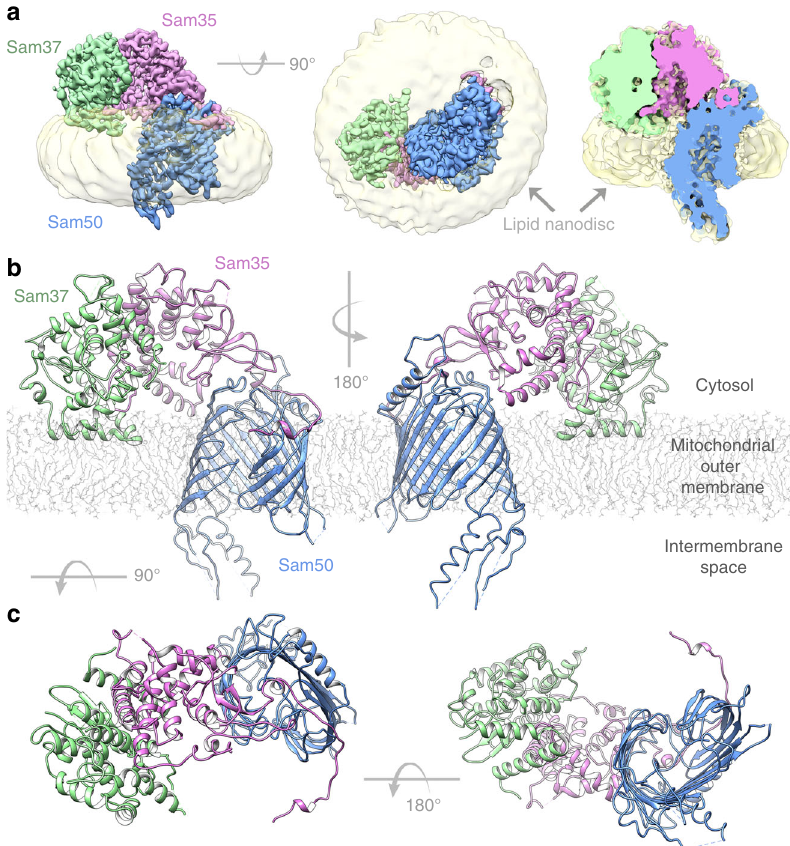
Fig. 2 Structure of the SAM complex in lipid nanodiscs. a The cryoEM density map of the SAM complex (Sam35 in orchid, Sam37 in pale green, and Sam50 in blue) with the nanodisc densities (transparent yellow) showing the membrane boundaries. A cross section is shown on the right. b Ribbon views of the SAM complex in the context of a model lipid bilayer. c Ribbon views from top (cytosol) and bottom (intermembrane space). See also Supplementary Fig. 3 and Table